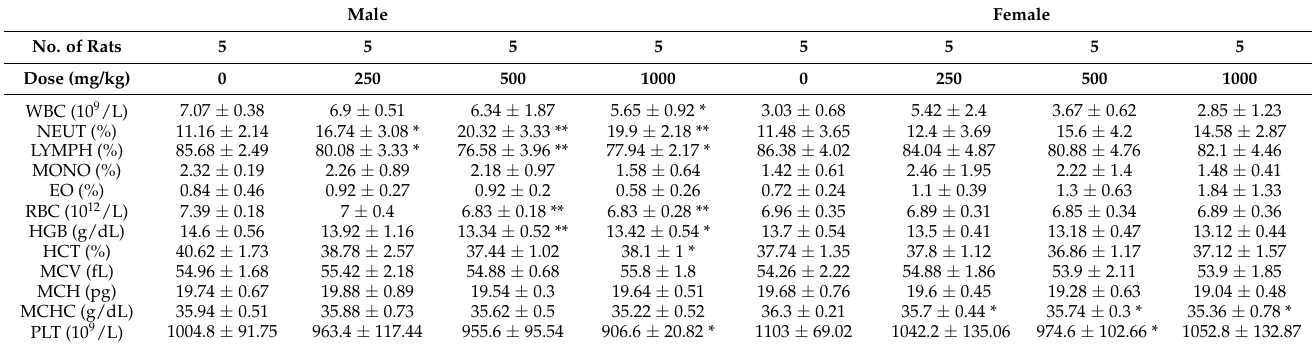
Table 2. Differential blood cells count data of male and female rats fed with 0, 250, 500, and